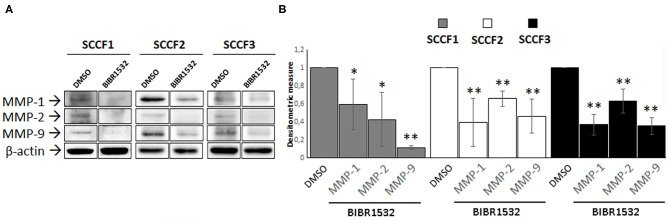
BIBR1532 down-regulates MMP-1/-2/-9 in FOSCC cell lines. (A) SCCF1, SCCF2, and SCCF3 were treated with BIBR1532 50 μM vs. DMSO and analyzed by Western blotting (WB) for MMP-1/-2/-9. Representative WB experiments showing lower MMP-1/-2/-9 expression at protein level in BIBR1532- vs. DMSO-treated cells are shown. Blots were stripped and reprobed for β-actin to ensure comparable protein loading and allow normalization. For each cell line, boxes are cut from the same gel at the same exposure time and properly aligned according to molecular standards loaded onto the gel. Full scans from original gels are shown in Supplementary Figure 4. (B) Mean densitometric values normalized for β-actin expression ± SD from at least two repeated, independent experiments. Changes in MMPs protein levels were calculated for SCCF1, SCCF2, and SCCF3 treated with BIBR1532 compared with their respective DMSO control set as 1 (statistically significant, *P < 0.05 and **P < 0.01).